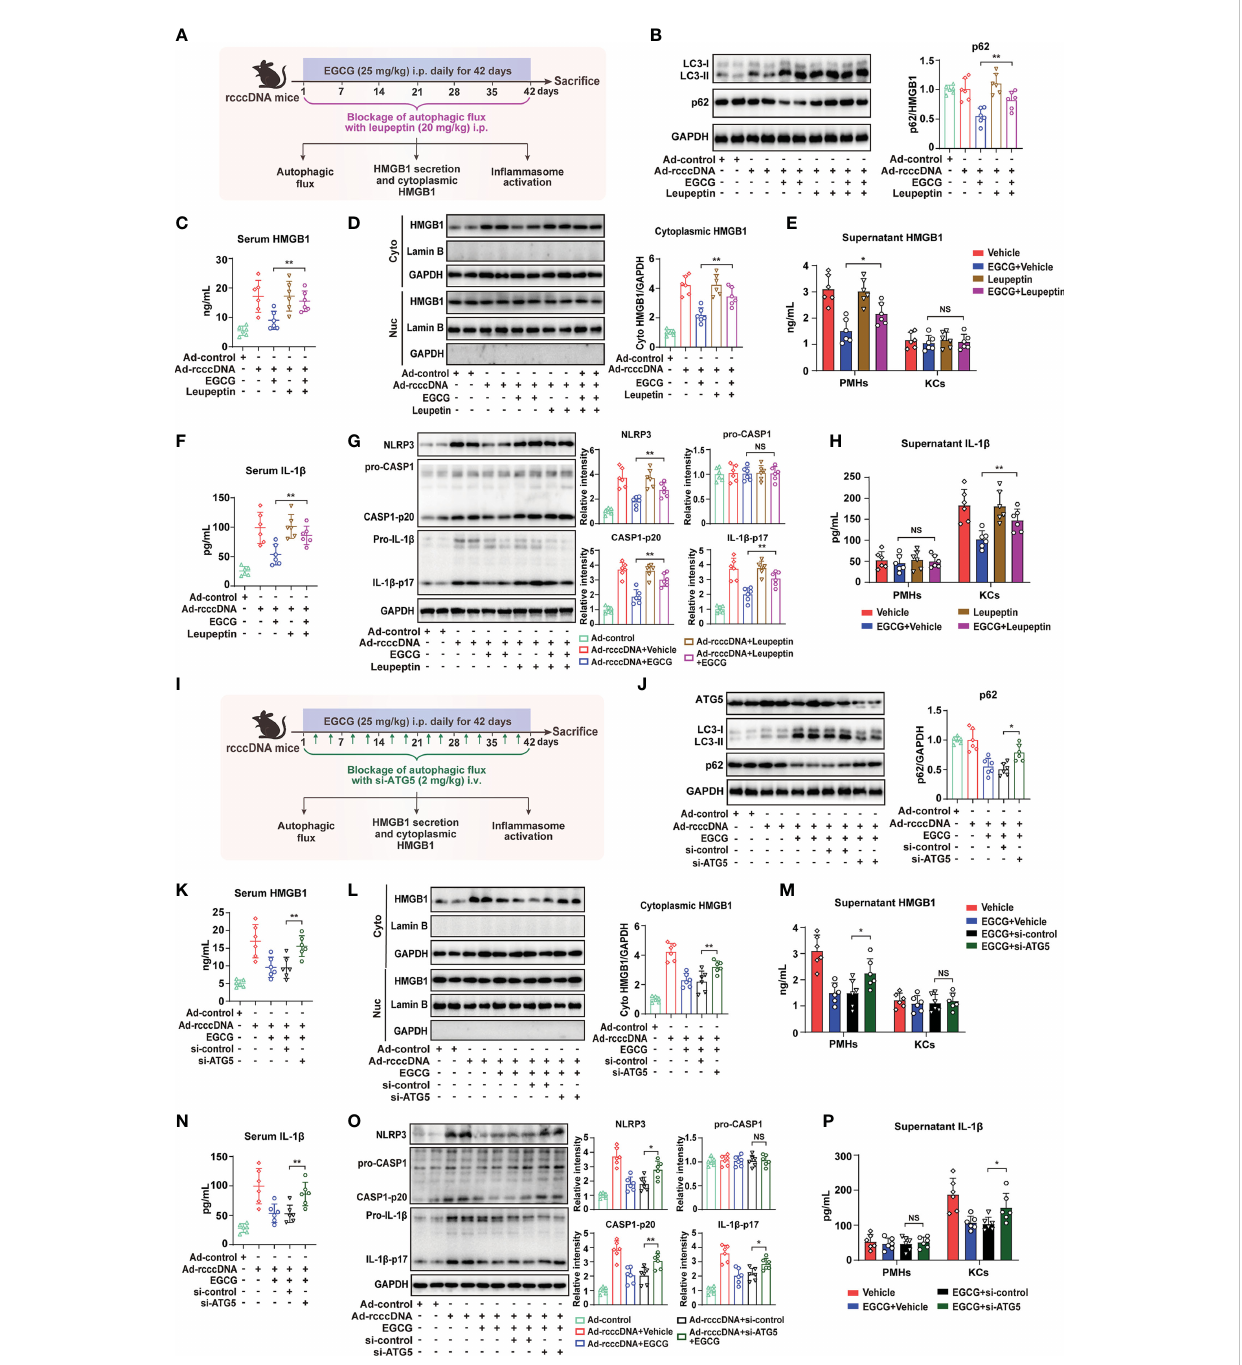
FIGURE 5 Blockage of autophagic fl ux reverses EGCG-mediated inhibition on HMGB1 secretion from hepatocytes and the subsequent macrophage NLRP3 in fl ammasome activation. (A – H) Schematic experimental setup: rcccDNA mice were treated with EGCG (25 mg/kg) daily for 42 days through i.p. injection in the presence of leupeptin (20 mg/kg), followed by the determination of autophagic fl ux, HMGB1 secretion and in fl ammasome activation (n = 6) (A) . Protein levels of LC3-II and p62 in liver tissues were determined by Western blotting. Right panel: relative protein level of p62 was determined by densitometric analysis, and the value from control group was set at 1.0 (B) . Serum HMGB1 levels were determined by ELISA (C) . HMGB1 protein levels in cytoplasmic and nucleic extracts of liver tissues were determined by Western blotting as in B (D) . HMGB1 protein levels in the supernatants of PMHs or KCs were determined by ELISA (E) . Serum IL-1 b levels were determined by ELISA (F) . Protein levels of NLRP3, pro- caspase-1, cleaved caspase-1 p20, pro-IL-1 b and cleaved IL-1 b p17 in liver tissues were determined by Western blotting as in B (G) . Supernatants IL- 1 b levels of PMHs or KCs were determined by ELISA (H) . (I – P) Schematic experimental setup: rcccDNA mice were i.p. injected with EGCG (25 mg/ kg) for 42 days, in which si-ATG5 (2 mg/kg) were i.v. injected twice a week to block the autophagic fl ux through tail vein, followed by the determination of autophagic fl ux, HMGB1 secretion and in fl ammasome activation (n = 6) (I) . Protein levels of ATG5, LC3-II and p62 (J) , serum HMGB1 levels (K) , HMGB1 protein levels in cytoplasmic and nucleic extracts of liver tissues (L) , HMGB1 protein levels in the supernatants of PMHs or KCs (M) , serum IL-1 b levels (N) , protein levels of NLRP3, pro-caspase-1, cleaved caspase-1 p20, pro-IL-1 b and cleaved IL-1 b p17 in liver tissues (O) and IL-1 b levels in the supernatants of PMHs or KCs (P) were determined as in B to (H) All data are shown as mean ± SEM and compared